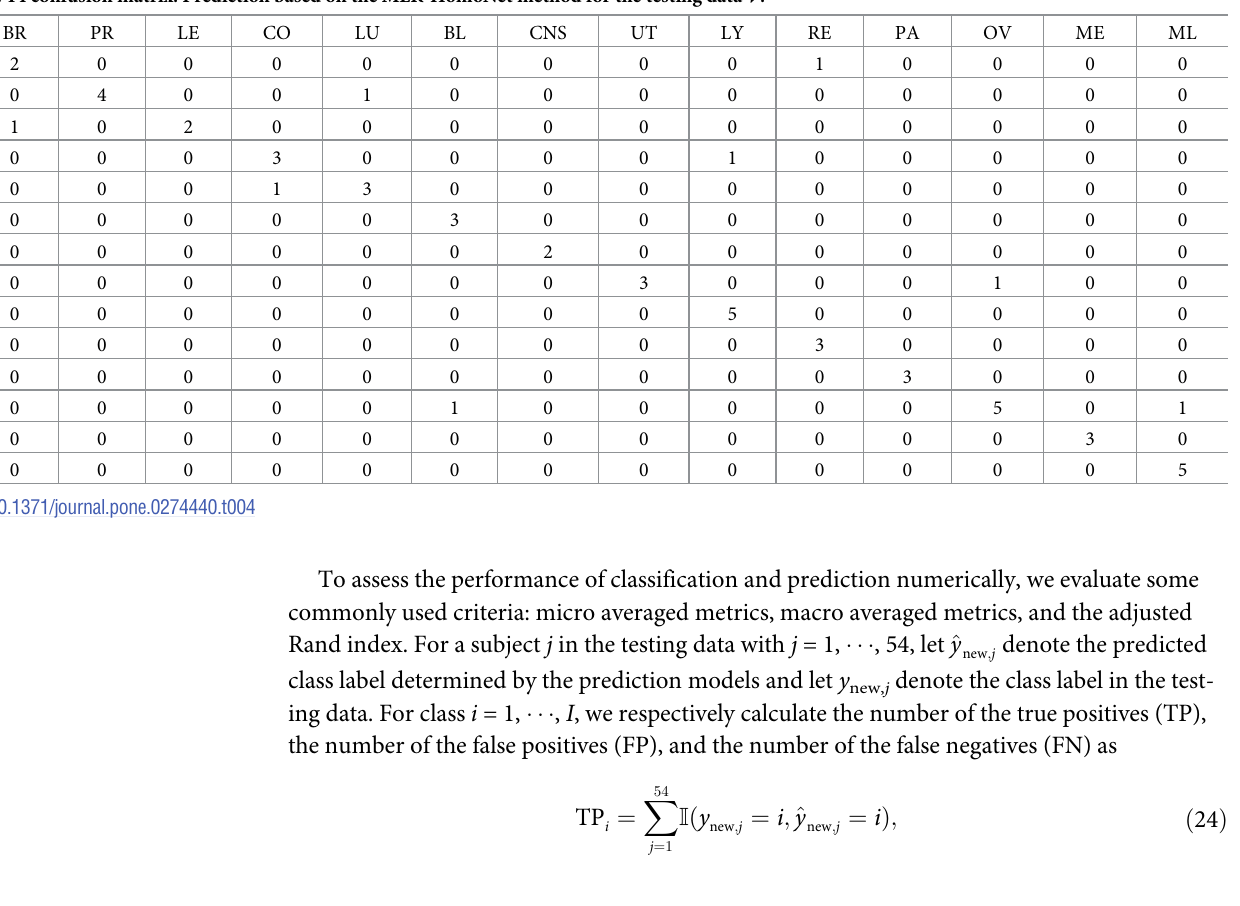
Table 4. A 14 × 14 confusion matrix: Prediction based on the MLR-HomoNet method for the testing data V .